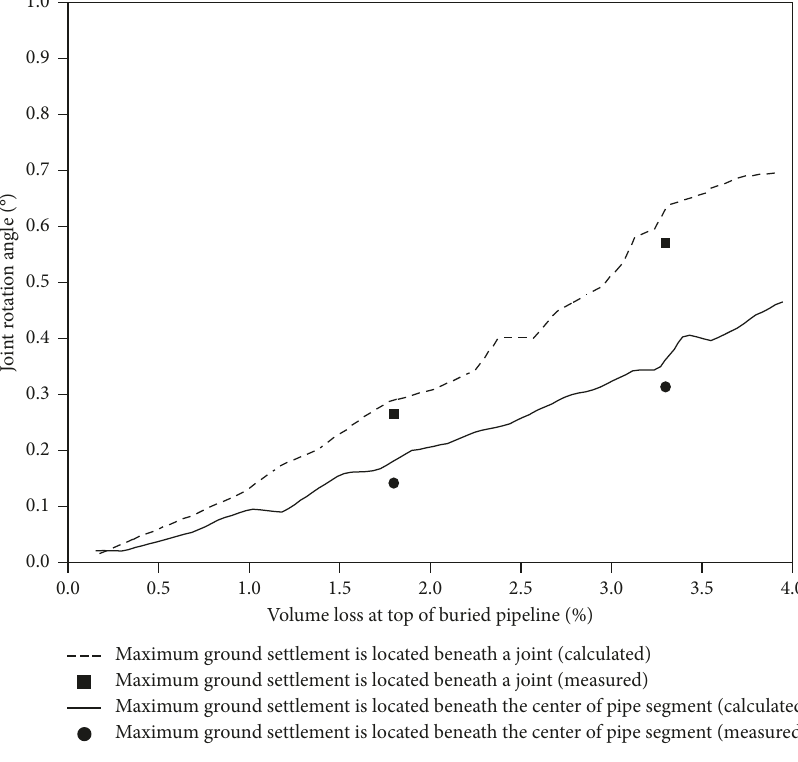
Figure 5: Comparison of measured and computed joint